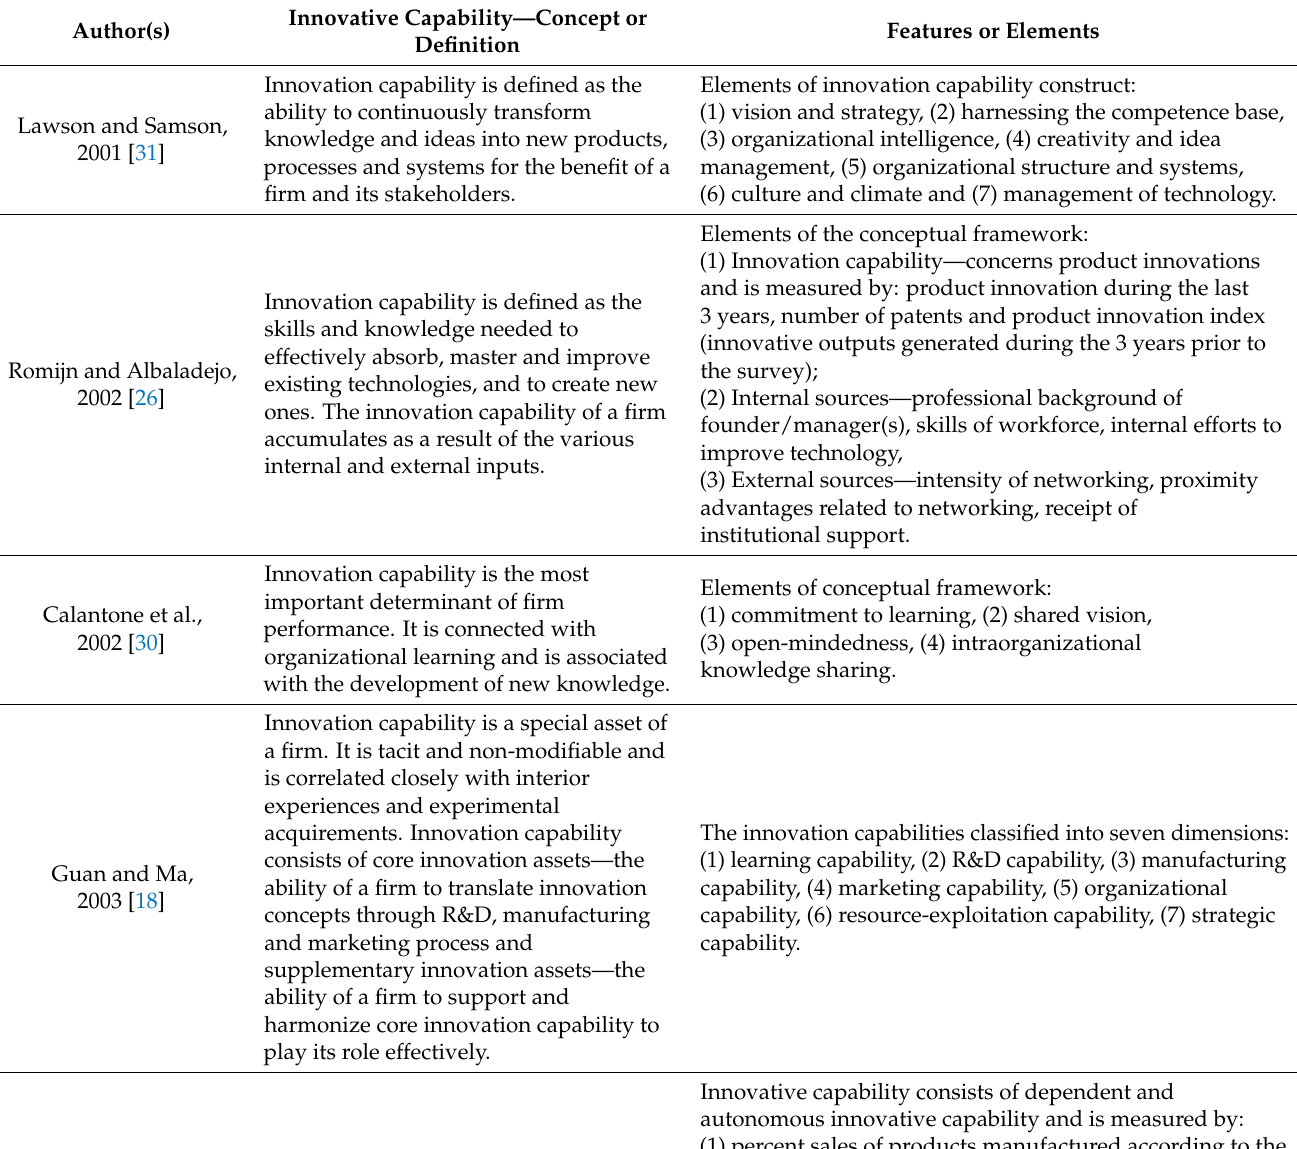
Table 1. Summary of the literature on innovative